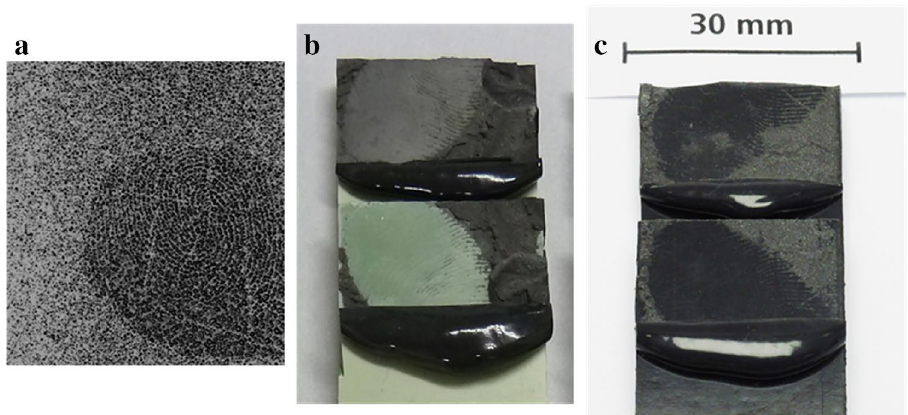
Fig. 3 Photographical images of a a contaminated ABS adherend surface before bond- ing as obtained after applying water aerosol with an auto- mated aerosol wettability test (AWT), and two pairs of ABS fracture images as obtained after lap-shear testing when using b green ABS-PMMA and c black R-ABS adherends